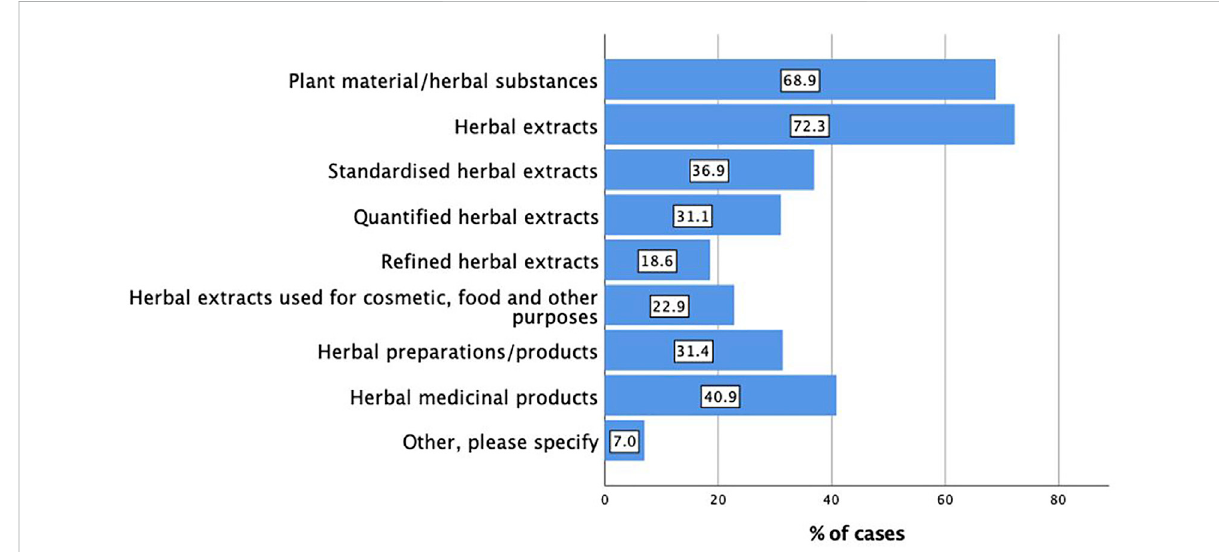
FIGURE 1 Main types of preparations used in pharmacological, toxicological and clinical/intervention studies (n = 328; multiple responses